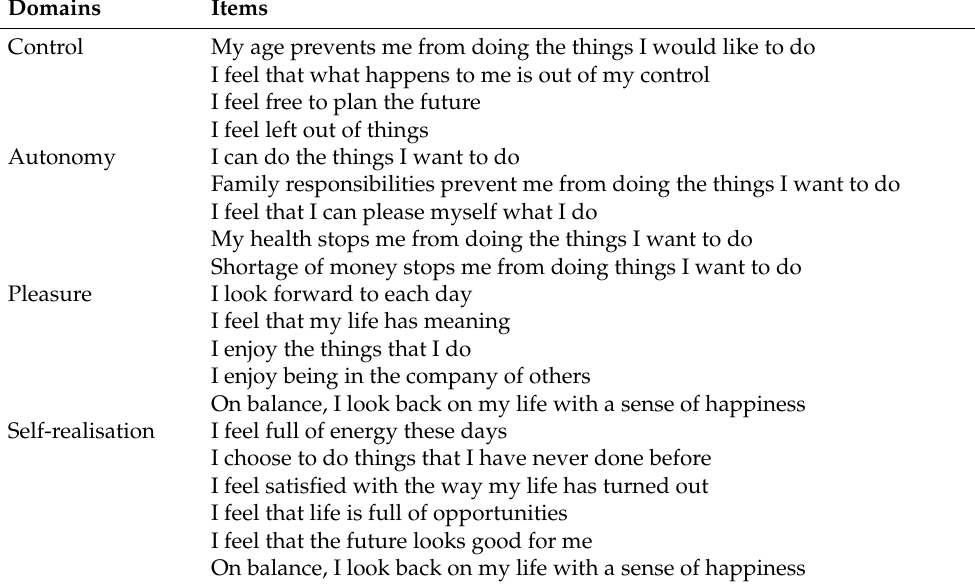
Table 1. Domains and items included in the CASP-19